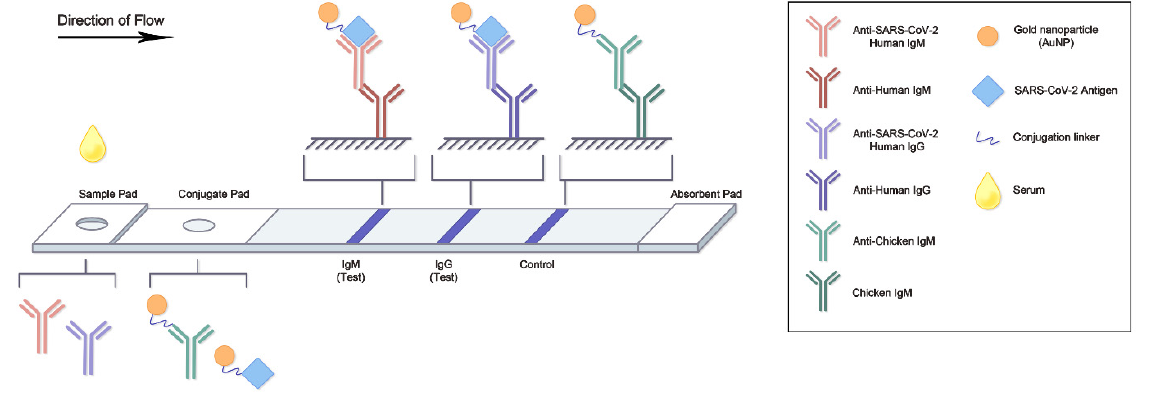
Figure 2. The scheme of neutralizing antibody LFA. After the drop of serum sample is placed on the sample pad, the sample moves to the conjugate pad by capillary action. In this part, the AuNP-antigen can be recognized by the neutralizing antibody. Antibody detection, including IgM and IgG, occurs in the next part; the antibody and AuNP-antigen complex show a signal in the test region. AuNP, gold nanoparticle; Ig, immunoglobulin; LFA, lateral flow assay; SARS-CoV-2, severe acute respiratory syndrome corona virus 2.